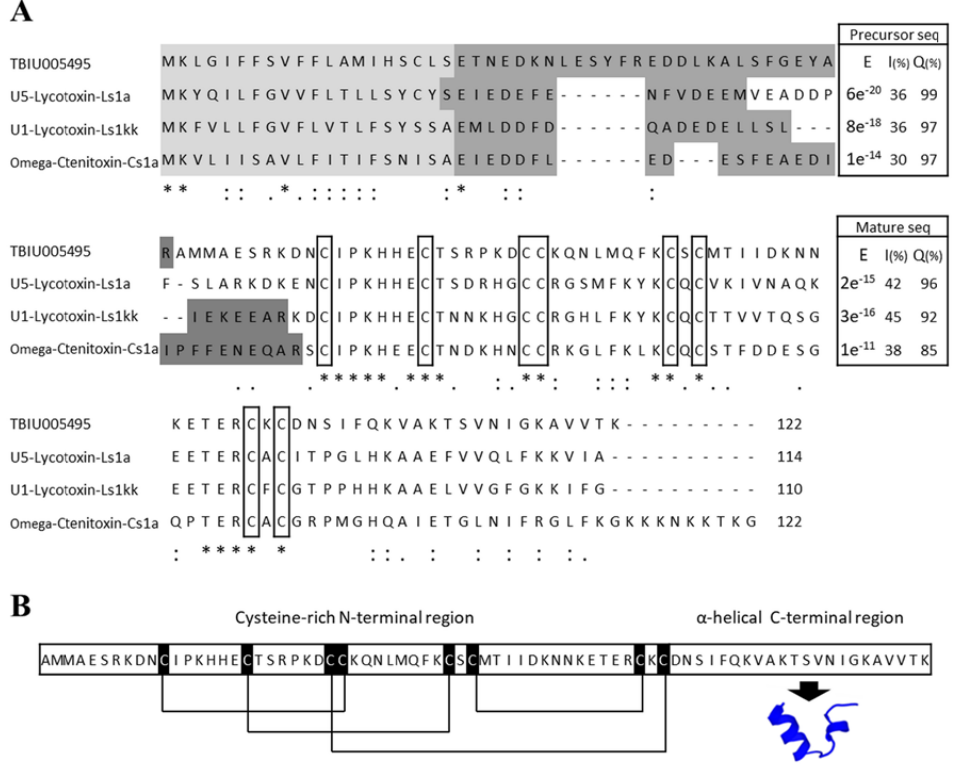
Figure 1. Multiple sequence alignment and structural representation of TBIU005495. ( A ) Multiple sequence alignment with other spider toxins showing significant sequence similarities with the signal peptide region (light gray), propeptide region (dark grey), and mature peptide. Conserved cysteine residues are enclosed in boxes. The symbols “*”, “:”, and “.” indicate perfect alignment, strong similarity, and weak similarity, respectively. Also, the blastP results using each precursor and mature sequence of TBIU005495 are presented with E-value (E), identity (I), and query coverage (Q). ( B ) An in silico analysis predicted that a mature sequence of TBIU005495 may have an N-terminal with disulfide bonds and a C-terminal helical domain. Disulfide bonds which were predicted by DISULFIND are known to form an ICK motif with a conserved cysteine pattern. C-terminal helix modeling was performed using the SWISS-MODEL, while purotoxin-2 was automatically selected as a template.